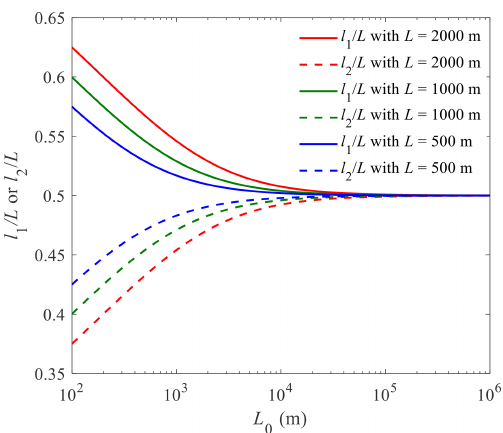
Figure 4. Widths of Unit 1 and Unit 2 versus L 0 for aquifers with different total width L